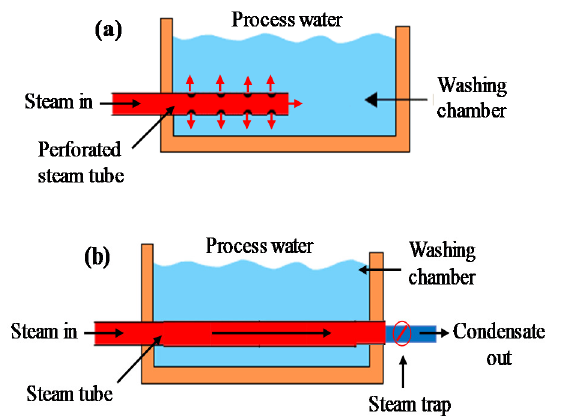
Fig. 4: Types of steam usage: (a) Direct steam use, and (b) Indirect steam use.